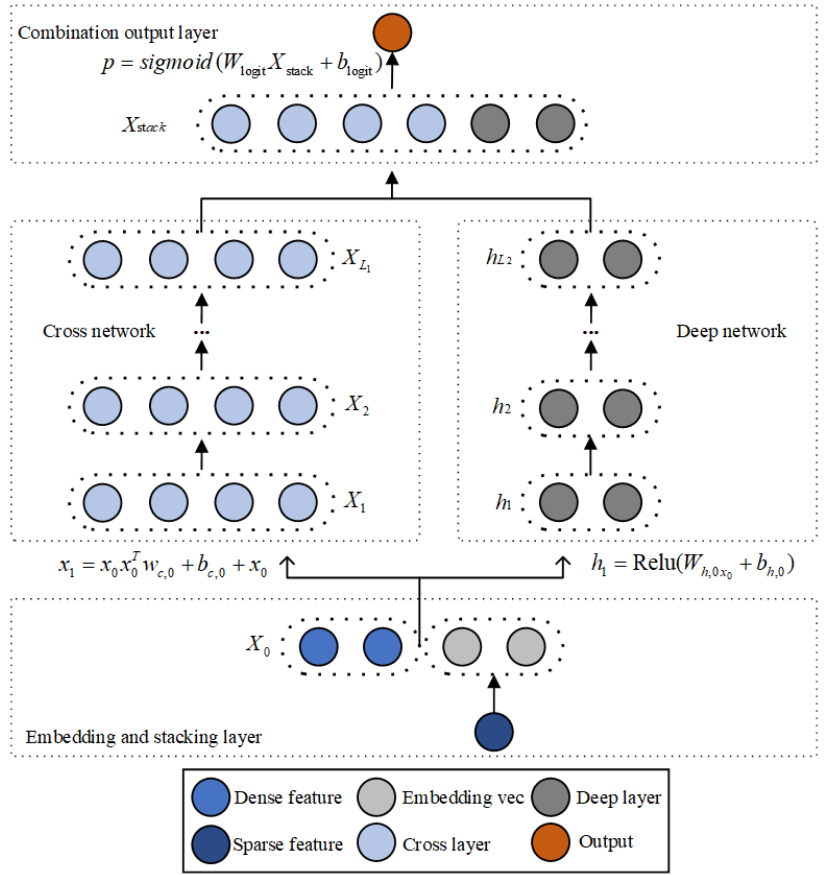
Figure 7. The structure of Deep and Cross. [22].